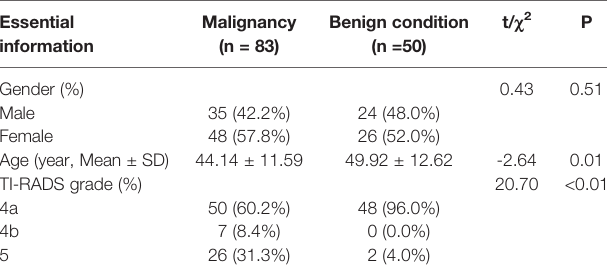
TABLE 1 | Basic characteristics of the patients. Essential information